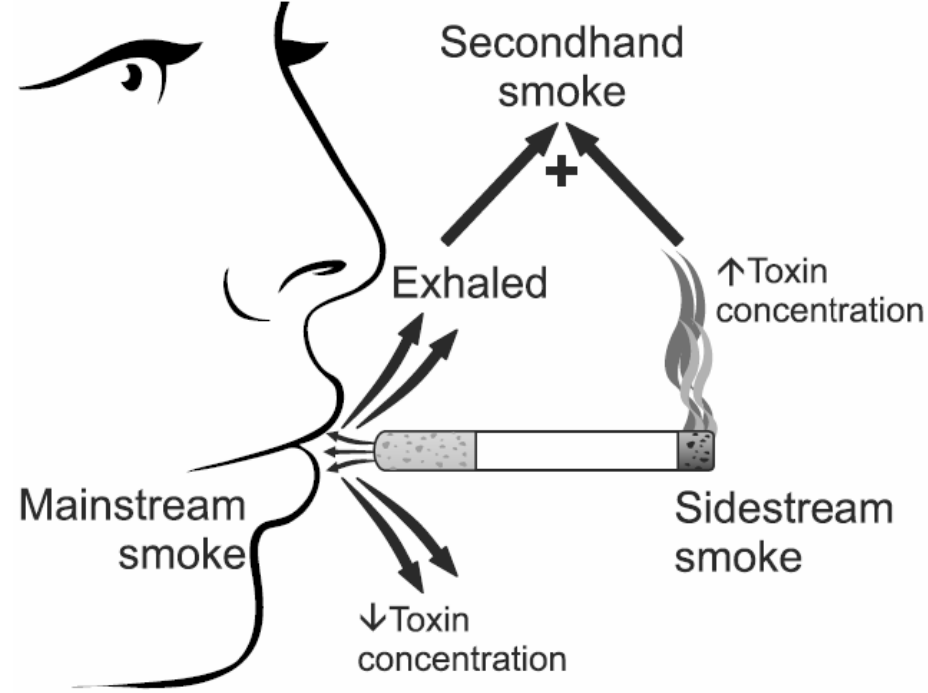
Figure 1. Composition of second-hand smoke. Sidestream smoke, containing toxins in higher concentrations compared to mainstream smoke, forms more than 80% of secondhand smoke.